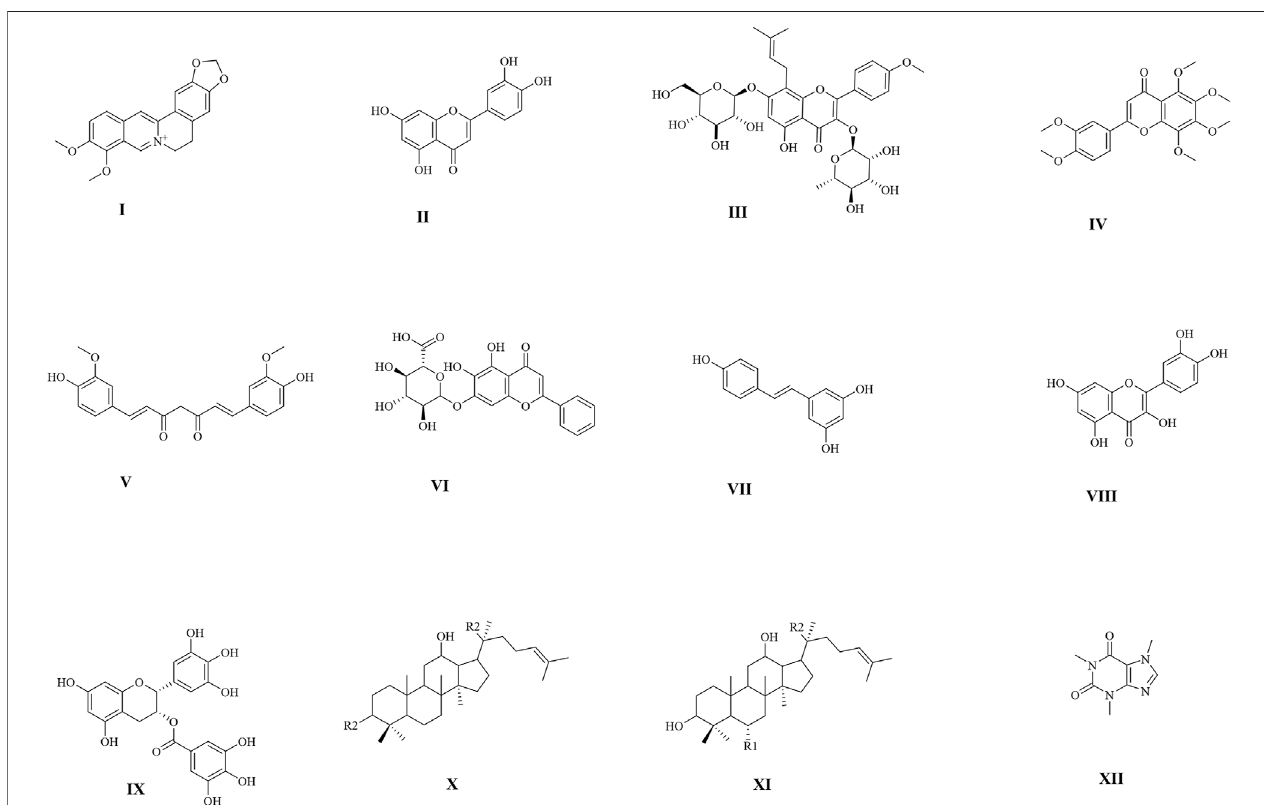
FIGURE 4 | 2D chemical structures of natural products with potential anti-aging properties that are considered to promote healthspan and improve aging-related diseases. (I) Berberine, (II) Luteolin, (III) Icariin, (IV) Nobiletin, (V) Curcumin, (VI) Baicalin, (VII) Resveratrol, (VIII) Quercetin, (IX) Epigallocatechin-3-gallate, (X) Ginsenoside protopanaxadiol {Ginsenoside Rb1 (R1 = -O-Glc-Glc; R2 = -O-Glc-Glc); Ginsenoside Rd (R1 = -O-Glc-Glc; R2 = -O-Glc); Ginsenoside Rb2 [R1 = -O-Glc-Glc; R2 = -O- Glc-Ara(p)];GinsenosideRg3(R1=-O-Glc-Glc;R2=OH)},(XI)Ginsenosideprotopanaxatriol[GinsenosideRe(R1=-O-Glc-Rha;R2=-O-Glc);GinsenosideRf(R1 = -O-Glc-Glc; R2 = -O-Glc); Ginsenoside Rg1 (R1 = -O-Glc; R2 = -O-Glc)], and (XII) Caffeine. The 2D chemical structures were s ketched using ChemBioDraw software ultra 12.0 (CambridgeSoft,